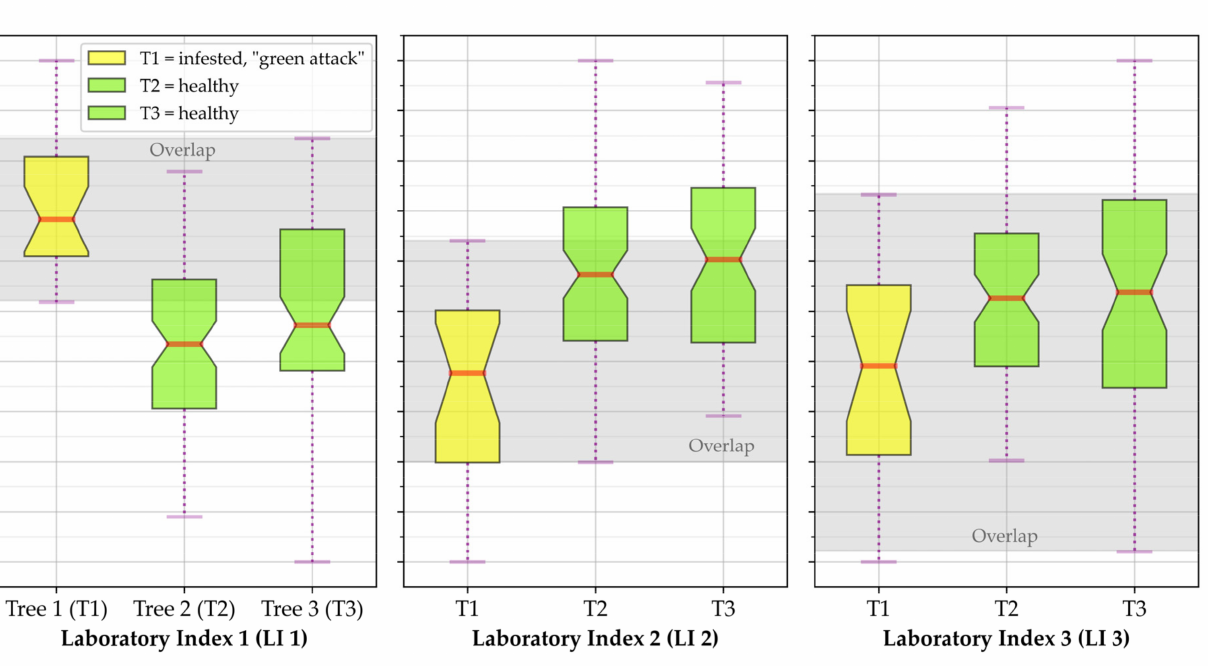
Figure 9. Normalized laboratory indices applied on the HySpex data for T1–3 (value range: P 5th to P 95th ). Because of the unknown positions, only T1–3 were considered. There is a large overlap area, especially for LI 3, between the infested spruce (T1) and the healthy spruces (T2 and T3). Accordingly, no suitable threshold value can be defined and a differentiation between infested and healthy spruces based on the laboratory indices (LI 1–3) is only possible to a limited